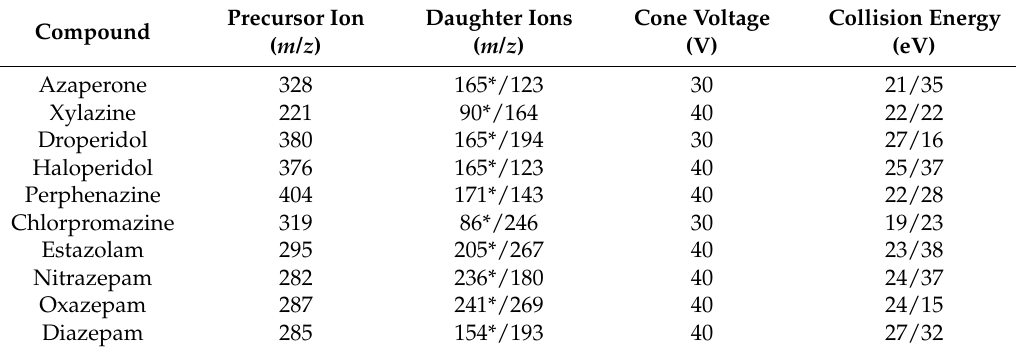
Table 2. MS/MS transitions and optimal